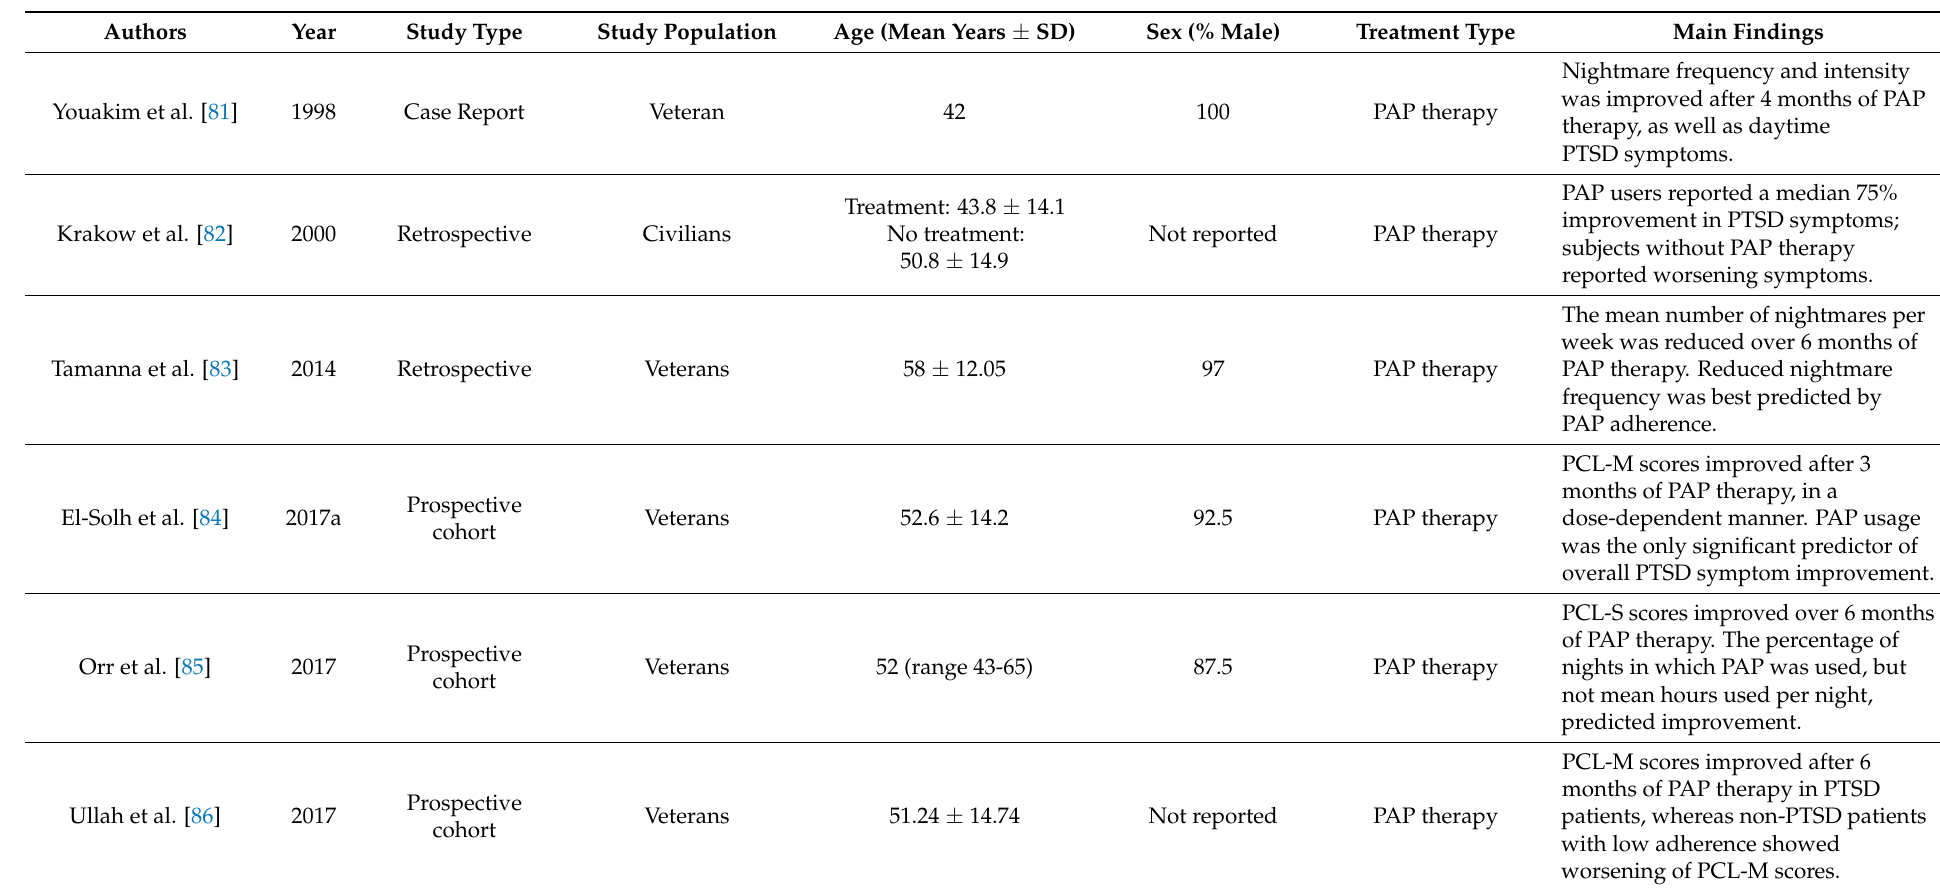
Table 1. Studies evaluating OSA treatment effects on PTSD. PAP, positive airway pressure. MRD, mandibular repositioning device. HNS, hypoglossal nerve PTSD checklist for the Diagnostic and Statistical Manual of Mental Disorders, Fifth